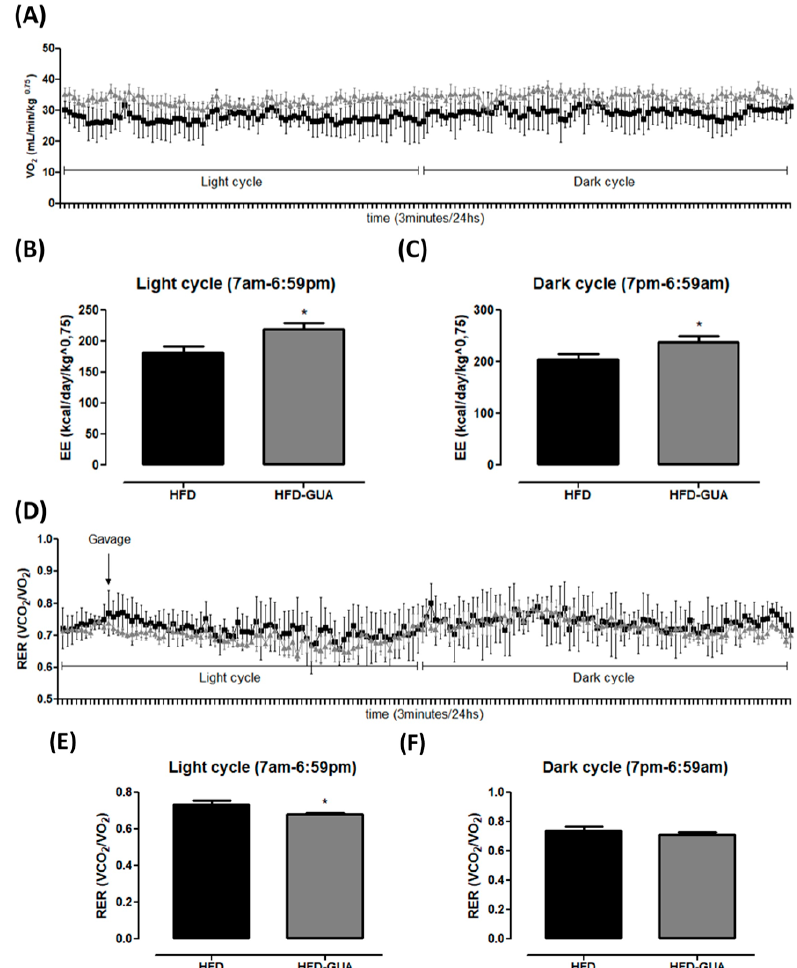
Figure 2. ( A ) Illustrative evolution of VO 2 (mL/min/kg 0.75 ) during 24 h after eight weeks of treatment. Light cycle (7 a.m. to 6:59 p.m.) and dark cycle (7 p.m. to 6:59 a.m.); ( B ) Energy expenditure (EE) (kcal/day/kg 0.75 ) in the light cycle after weigh weeks of treatment; ( C ) EE (kcal/day/kg 0.75 ) in the dark cycle after weigh weeks of treatment; ( D ) Illustrative evolution of Respiratory exchange ratio (RER) during 24 h after eight weeks of treatment; ( E ) Respiratory exchange ratio (RER) in the light cycle; ( F ) Respiratory exchange ratio (RER) in the dark cycle. Black line/bars correspond to HFD-group ( n = 6) and grey line/bars correspond to HFD-GUA group ( n = 6). * p < 0.05.